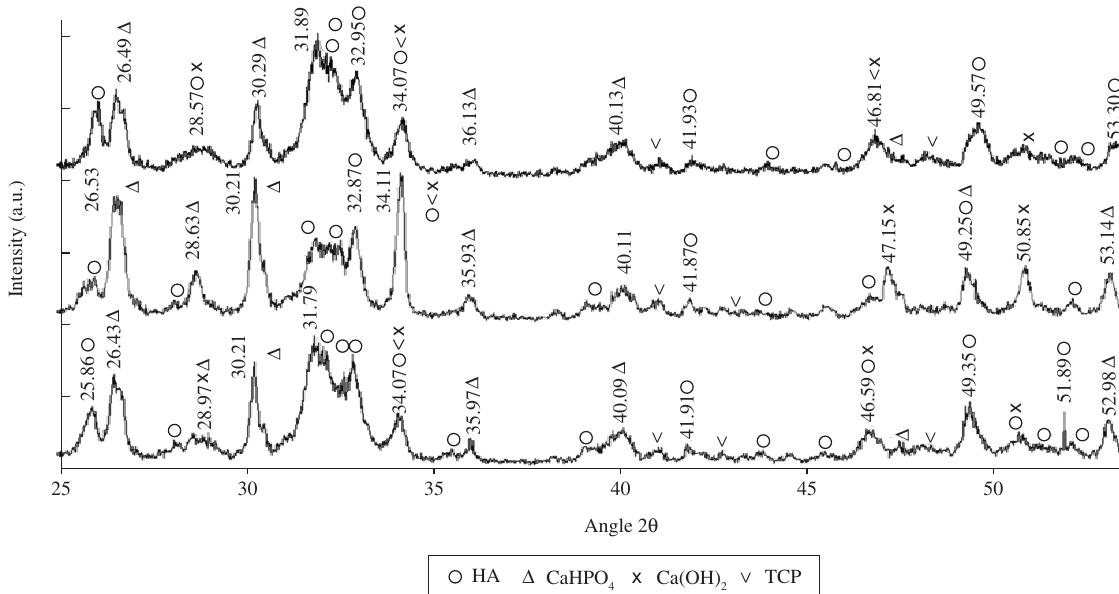
Figure 2. XRD patterns of non sintered HA 1, 2 and 3.